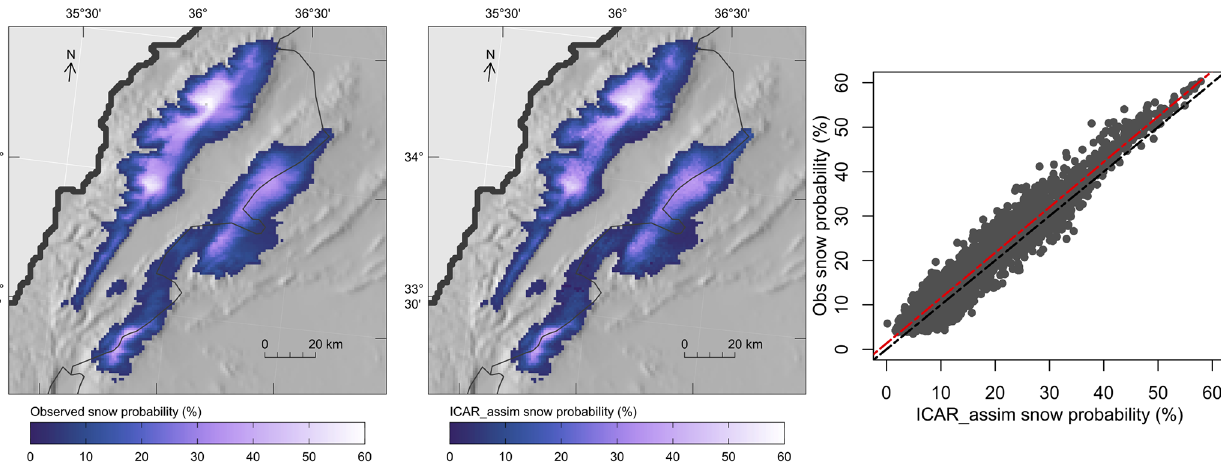
Figure 7. Snow probability spatial comparison between observed MODIS products and